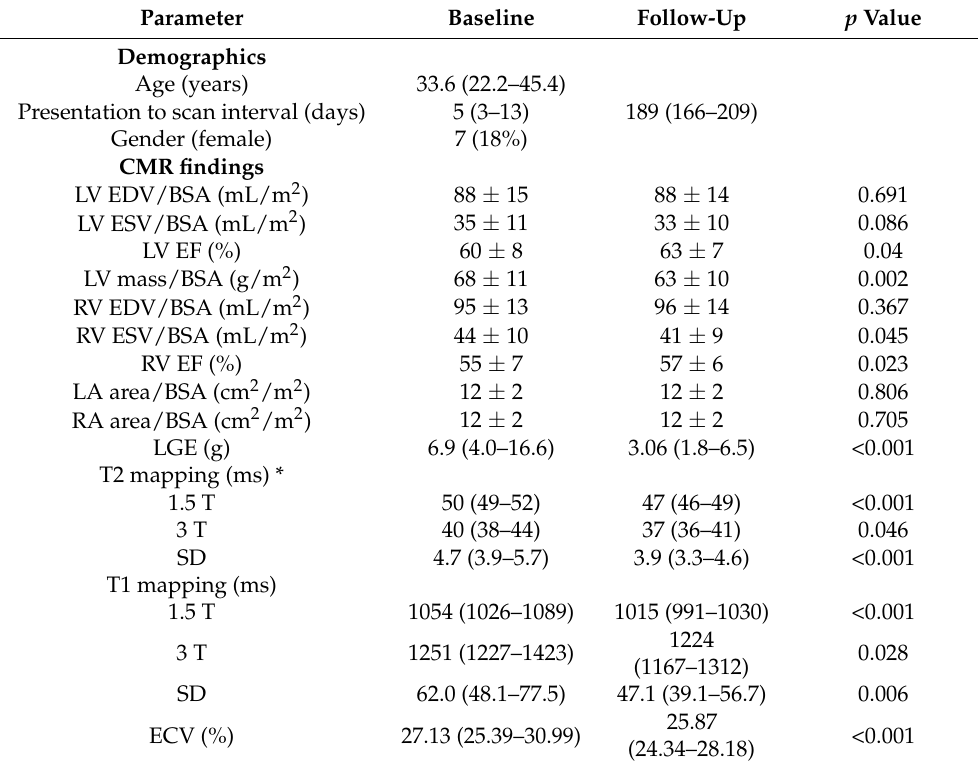
Table 3. Characteristics of patients undergoing baseline and follow-up CMR ( n =